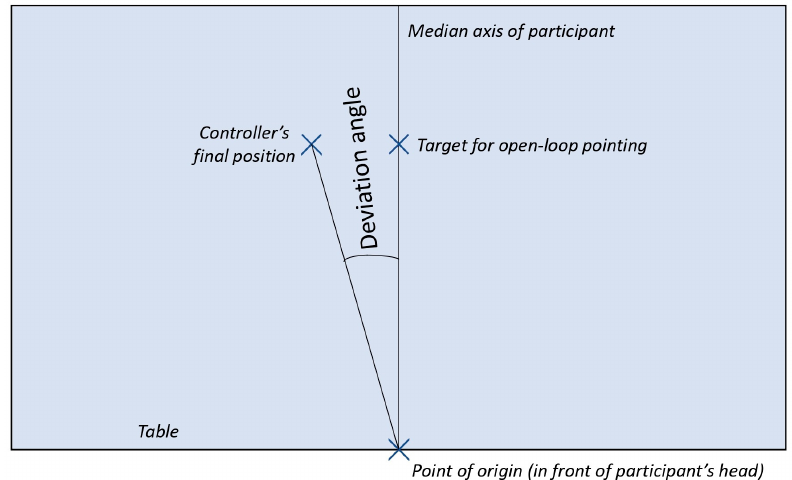
Figure 3. Method of calculating the angle of deviation.